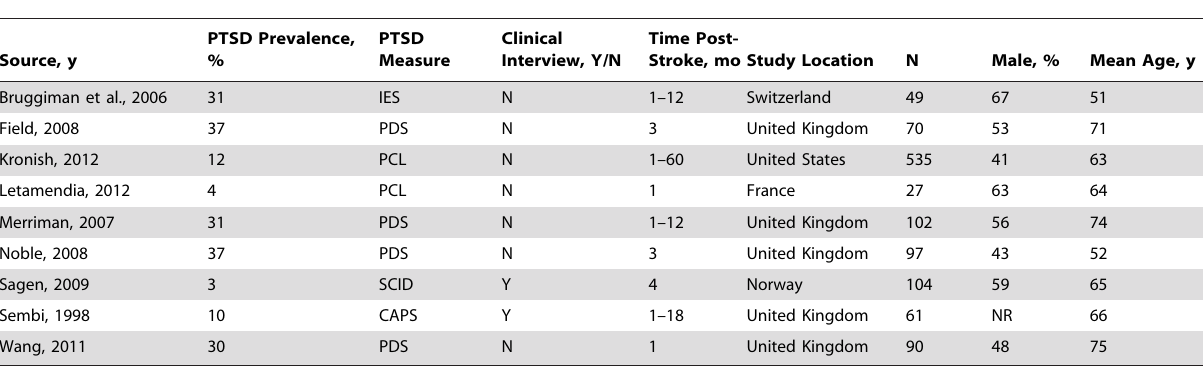
Table 1. Characteristics of Studies on the Prevalence of Stroke-Induced PTSD.